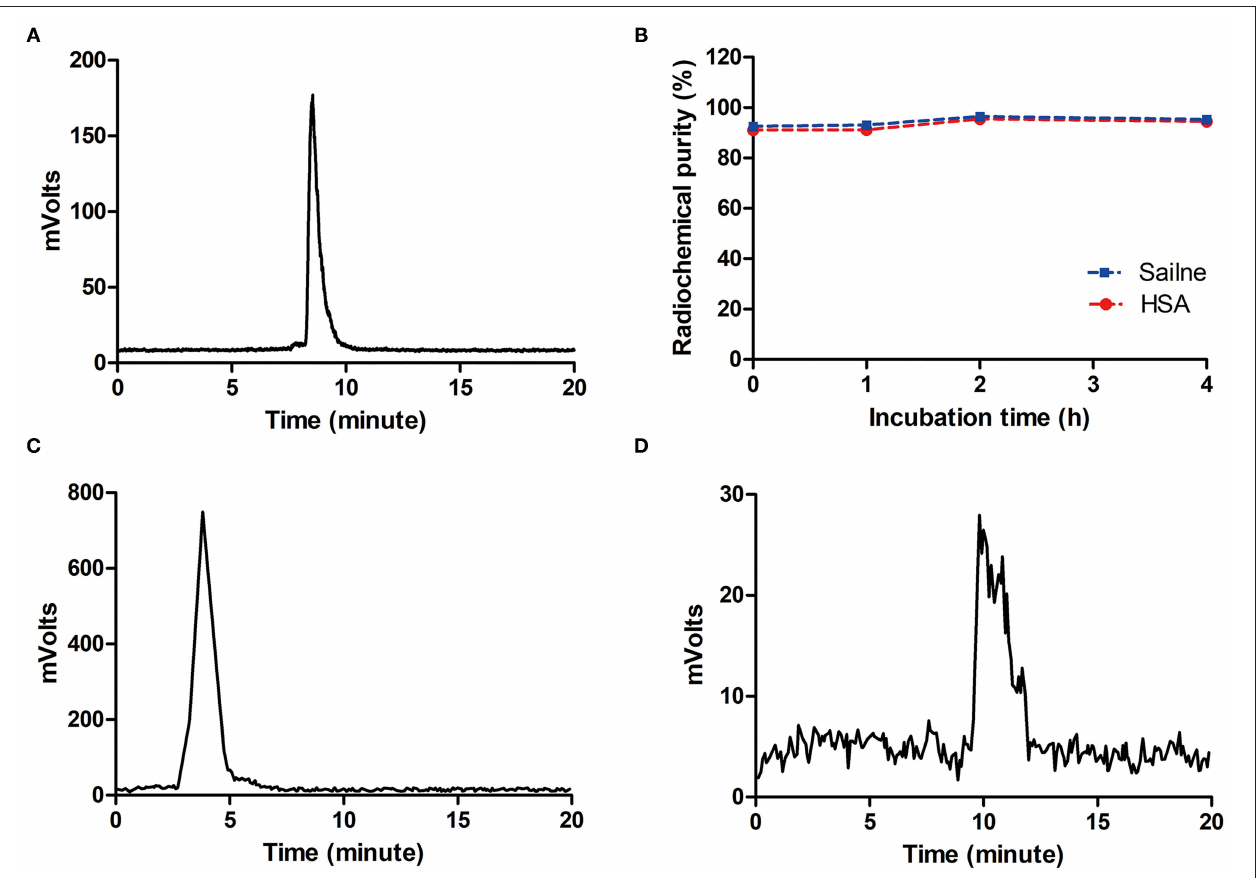
FIGURE 2 | HPLC chromatograms of the [ 18 F]AlF-NOTA-HER2 affibody (A) and 18 F − (C) . In vitro stability of the [ 18 F]AlF-NOTA-HER2 affibody in saline and 5% HSA (B) and in vivo stability in blood for 30min (D) . HPLC, high-pressure liquid chromatography; HAS, half-normal saline.